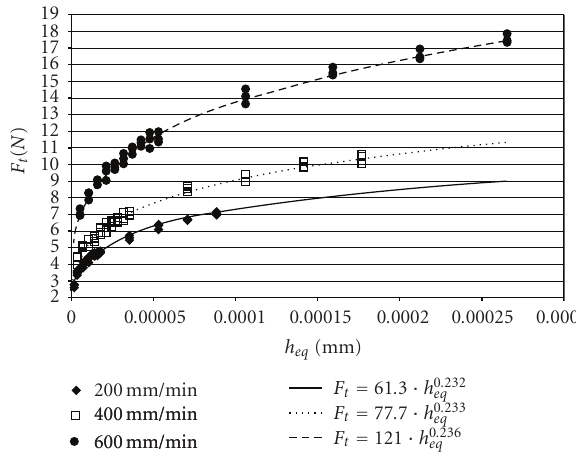
Figure 3: Comparison of model and experimental data of F t versus h eq and v a .